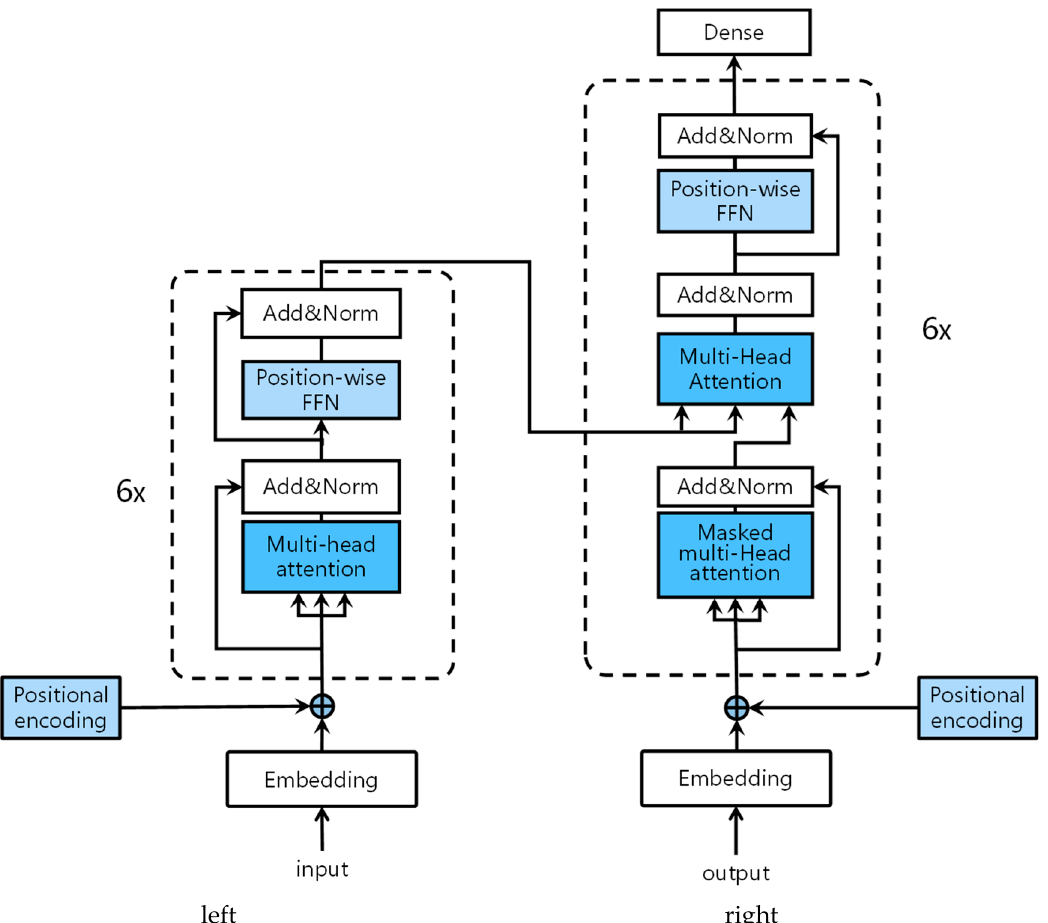
Figure 3. Transformer encoder-decoder architecture. The figure on the left is the encoder of the transformer and the figure on the right is the decoder of the transformer [15].